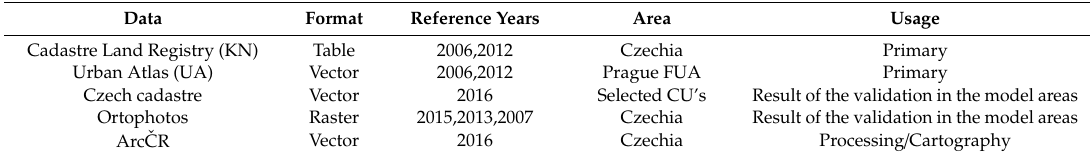
Table 1. The list of data used.